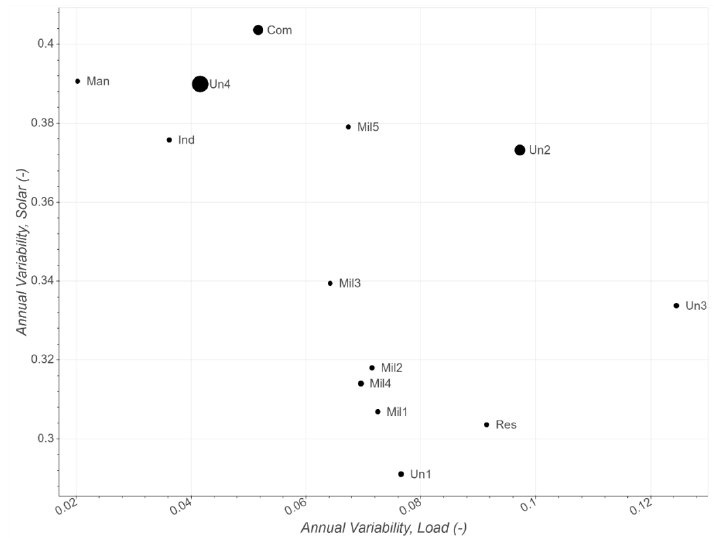
Figure 10. Scatter plot comparing the absolute value of OF deviation of each case as a function of solar variability ( y -axis) and load variability ( x -axis). The size of the circle represents the OF deviation of each case.